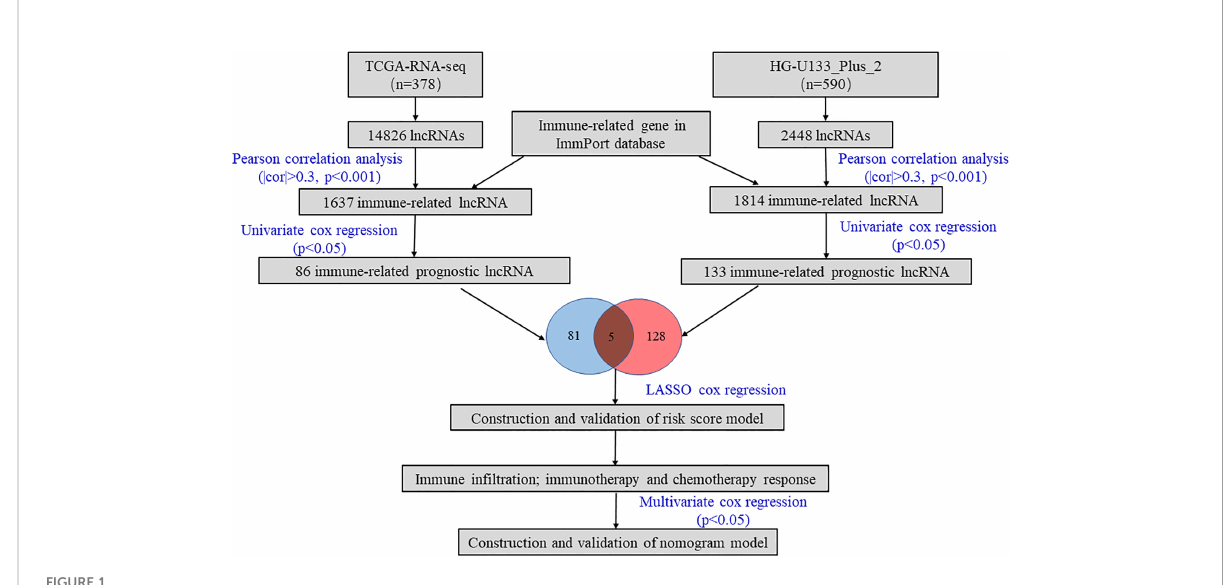
FIGURE 1 The work fl ow of this